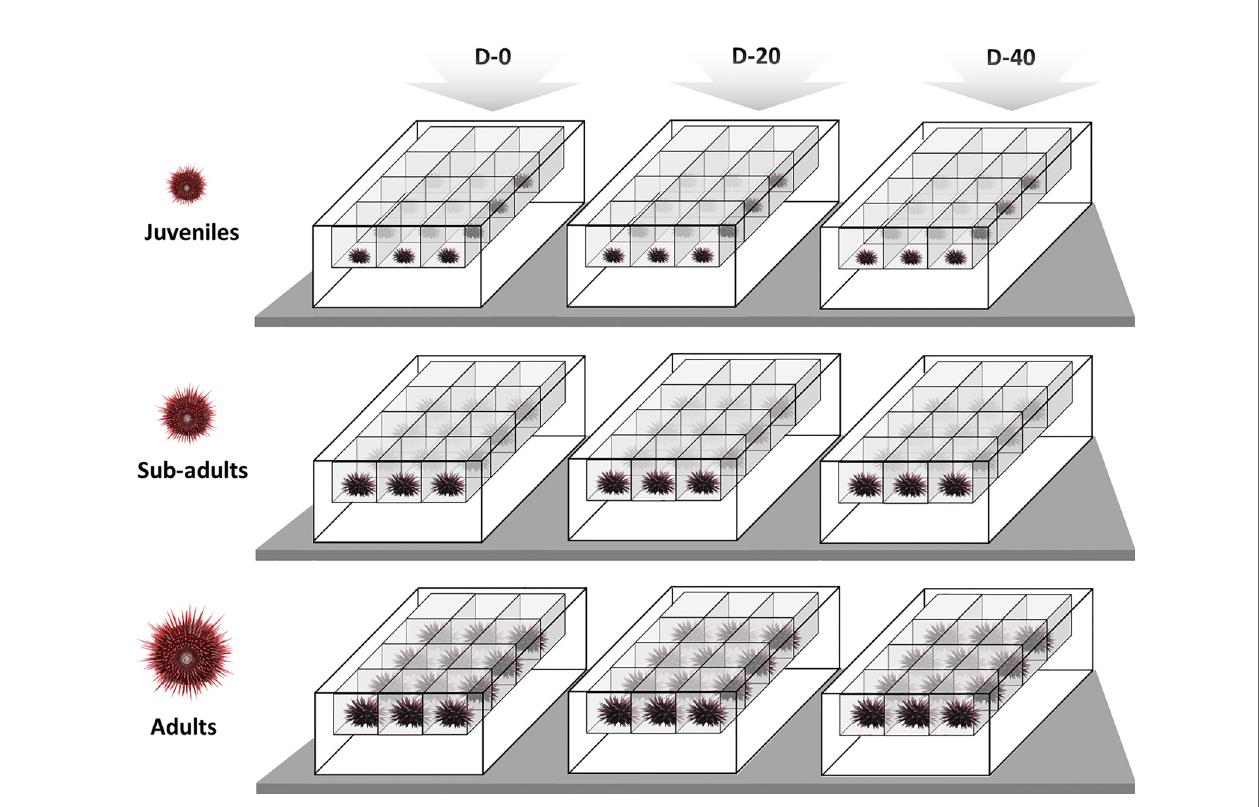
FIGURE 1 | Representation of the experimental design: above the three experimental diets administrated, D-0 (100% vegetables, 0% fi sh meal); D-20 (80% vegetables, 20% fi sh meal); D-40 (60% vegetables, 40% fi sh meal), and at each level the respective P. lividus size classes, juveniles (15-25 mm); sub-adults (25-35 mm); adults (45-55 mm). Twelve sea urchins were employed in each condition, individually placed in feeding boxes within same RAS.